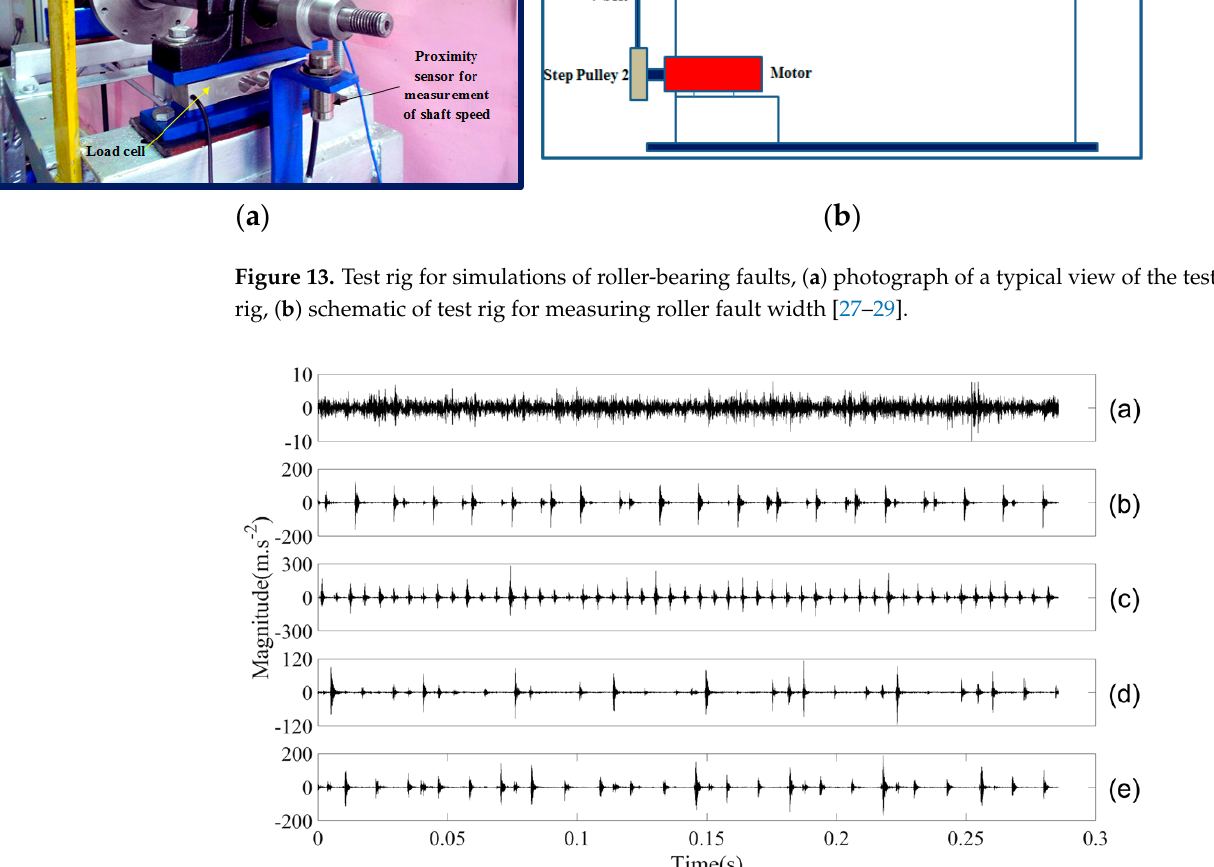
Figure 14. Five types of roller-bearing vibration data, where ( a – e ) are for normal, IR, OR, RO1, and RO2 conditions, respectively.